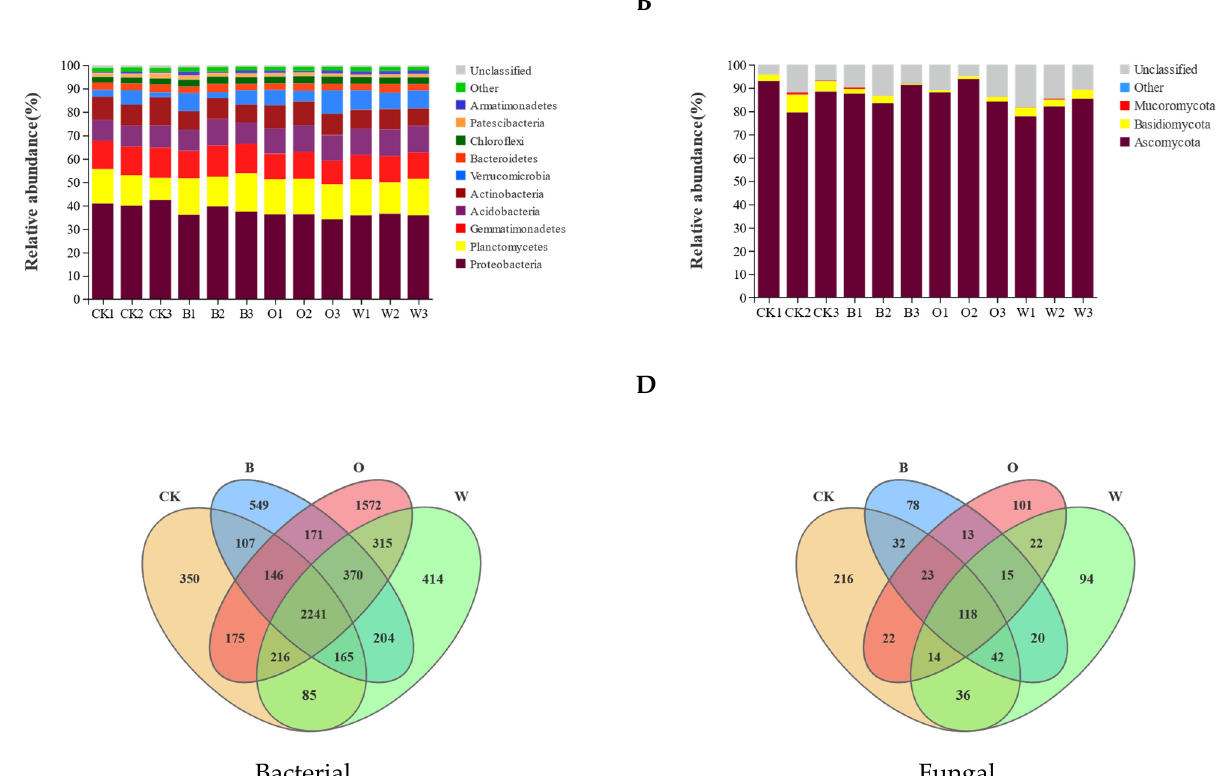
Figure 5. Relative abundances of bacterial ( A ) and fungal ( B ) phyla and Venn diagram analyses of bacterial ( C ) and fungi ( D ) in soil of different treatments. Bacterial and fungal phyla with average relative abundance > 1% are shown and do not contain unclassified taxa. Data are represented as the means of three independent replicates. Venn diagram ( C , D ) demonstrates the numbers of shared and unique observed OTUs at 97% similarity among treatments.